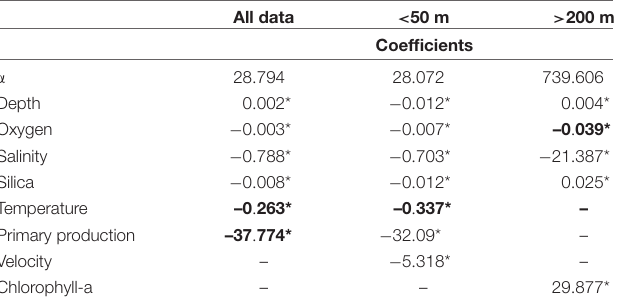
TABLE 6 | Coefficients and most important variable for the best GLM of each data (all data; < 50 m; > 200